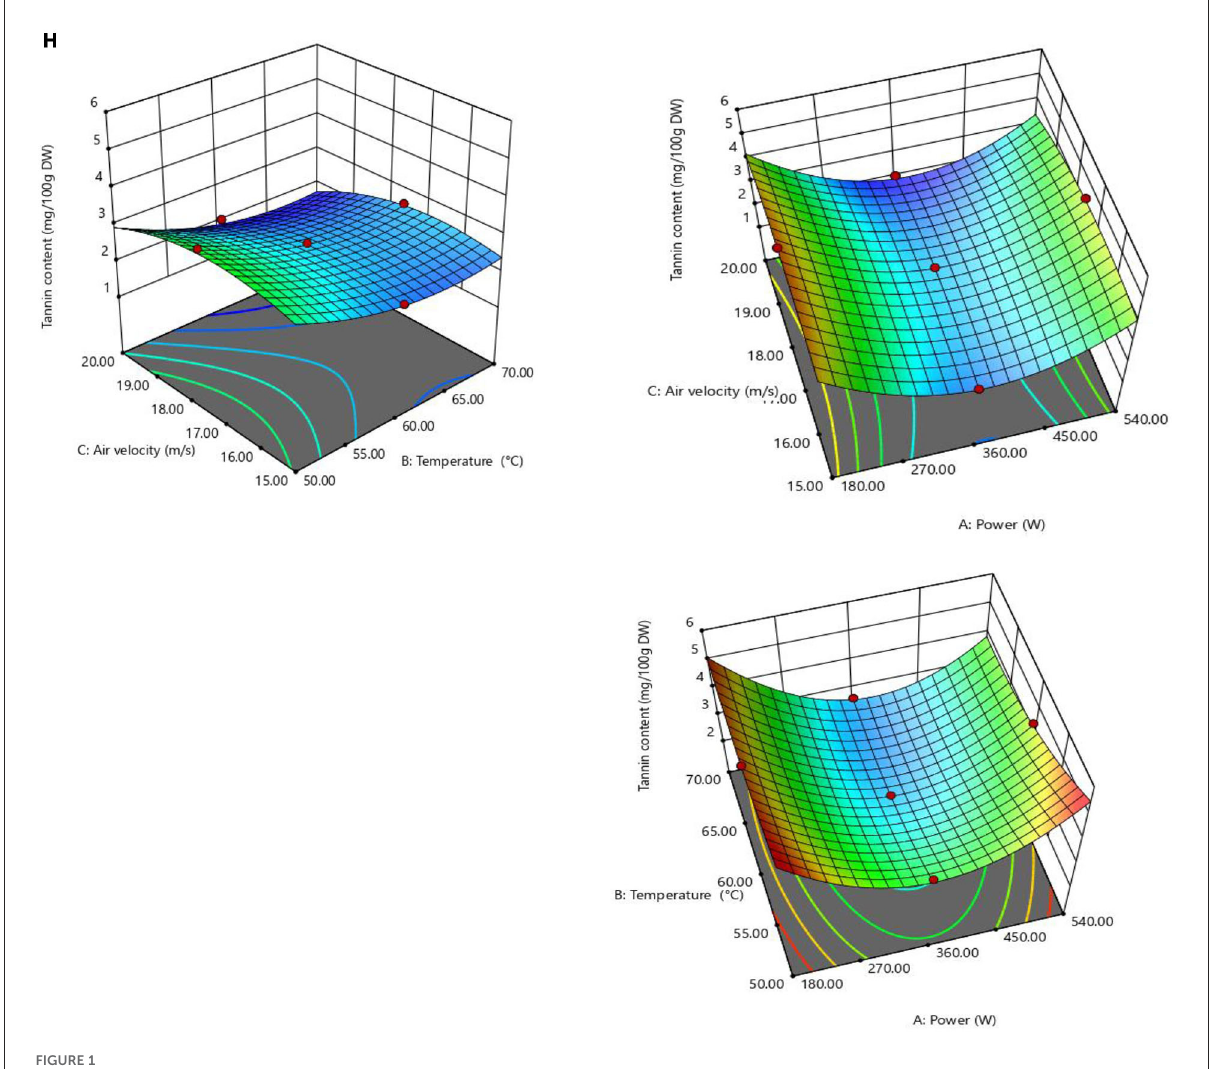
filtrate. The presence of tannins in the sample is indicated by the color change blue-black or brownish green